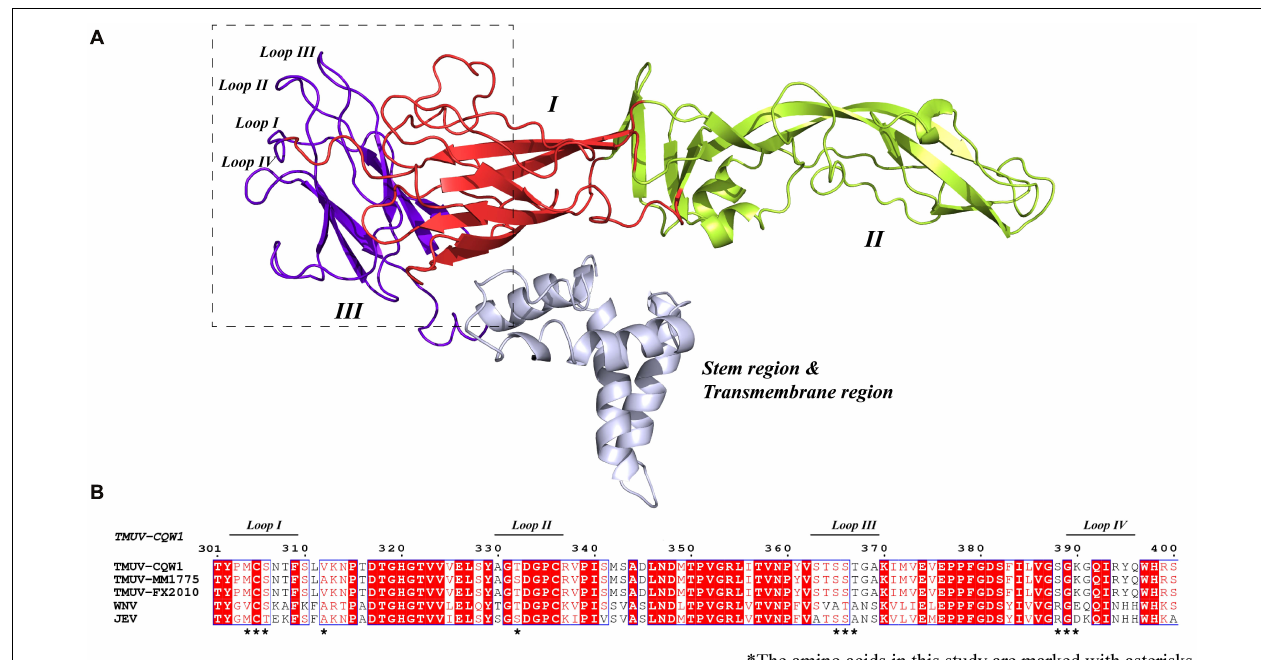
FIGURE 1 | (A) Side view of structural conformation of E protein monomer, the homology model building of Tembusu virus (TMUV) E protein based on the resolved cryo-EM structure of the Zika virus (ZIKV) E protein (PDB ID: 5IZ7) using SWISS-MODEL. The domain I, domain II, domain III, and stem region and transmembrane region are shown in red, lemon yellow, purple-blue, and blue white. (B) Alignment of E protein sequences from TMUV (CQW1: AIU44176.1, FX2010: AWV66902.1, MM1775: AWV66903.1), West Nile virus (WNV) (NP_776014.1), and Japanese encephalitis virus (JEV) (BAD81042.1) using MEGA7, and ESPript was used for graphical enhancements. The loop regions in A are marked with a horizontal line. The selected amino acids in this study are marked with asterisks.